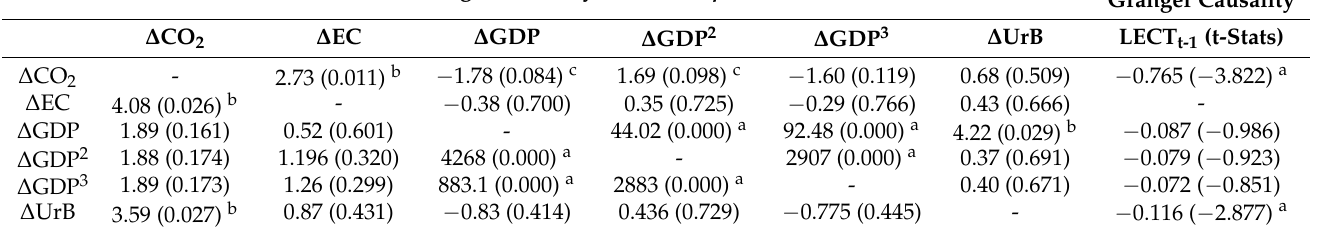
Table 6. Granger causality analysis.